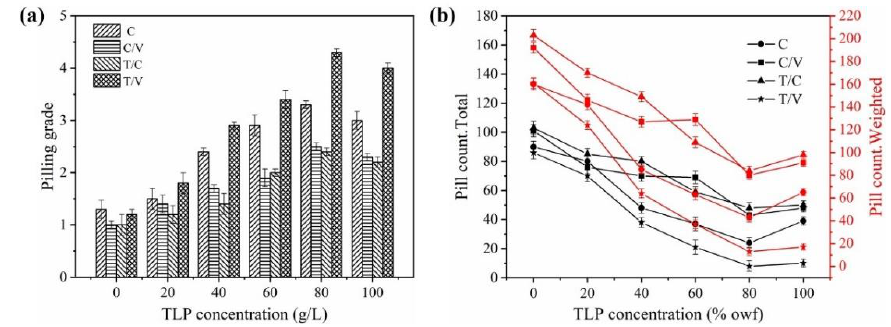
Figure 3. Pilling grade ( a ) and pill count ( b ) of fabrics treated with the pad–dry–cure process at various TLP